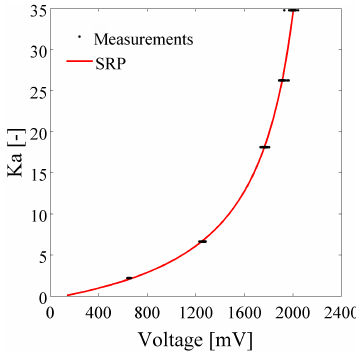
Figure 2. Sensor output of 60 SPADE sensors in five reference liq- uids ( K a refers to dielectric permittivity). The fitted “universal” cal- ibration relationship (Eq. 3) is also